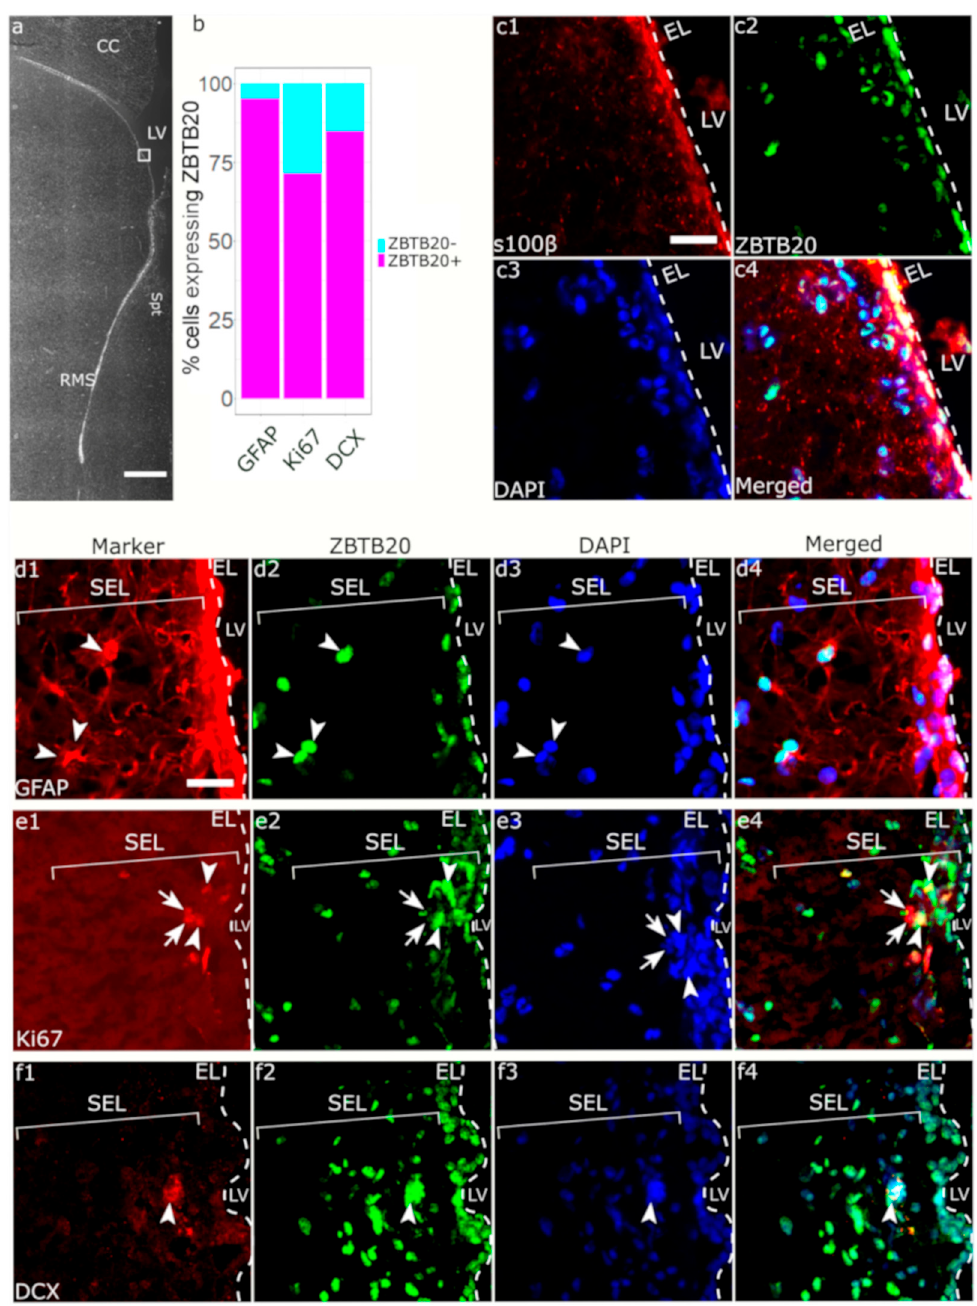
Figure 2. Phenotypic characterization of ZBTB20 + cells in the primate SVZa. ( a ) Low magnification image showing the relative position of the higher magnification micrographs in the other panels; ( b ) stacked bar plot summarizing the percentage of co-expression of ZBTB20 by specific cell popu- lations defined by the markers shown on the plot; ( c1 – c4 ) the EL is defined by high s100 β expression, all ependymal cells are s100 β + /ZBTB20 + ; ( d1 – d4 ) most GFAP + cells in SEL are ZBTB20 + (arrowheads); ( e1 – e4 ) a few Ki67 + cells can be detected in SEL, some are positive (arrowheads) or negative (arrows) for ZBTB20; ( f1 – f4 ) DCX + cells were rare in SEL, arrows depict a DCX + /ZBTB20 + cell cluster. CC— corpus callosum; EL—ependymal layer; LV—lateral ventricle; RMS—rostral migratory stream; Spt—septum; SEL—subependymal layer. Scale bar: 1 mm ( a ), 25 μ m ( c – f ).